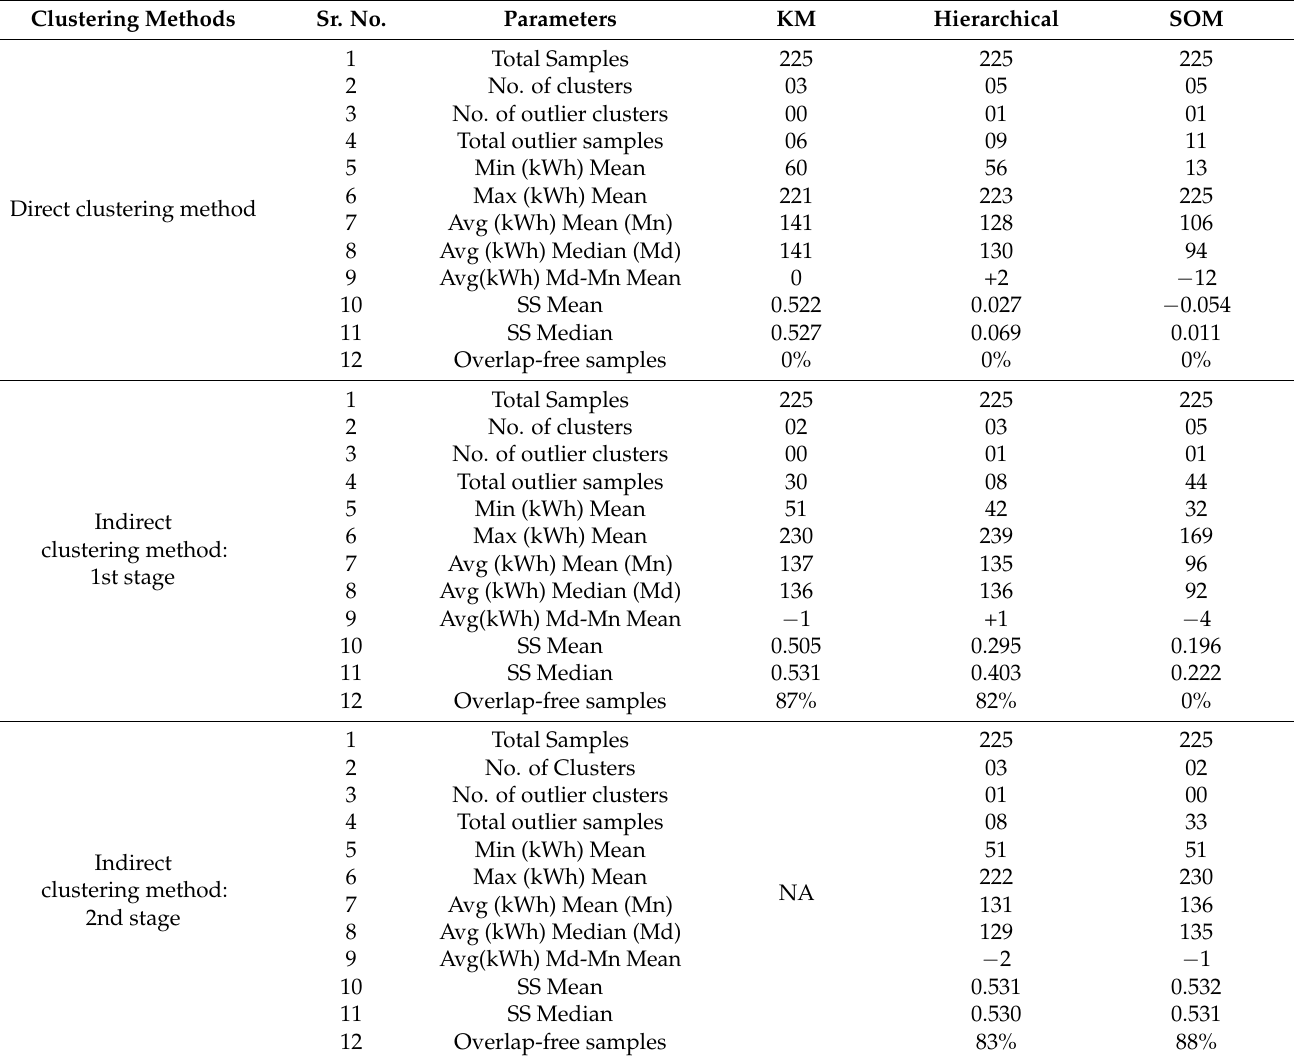
Table 11. Comparative result analysis for direct and indirect clustering methods.